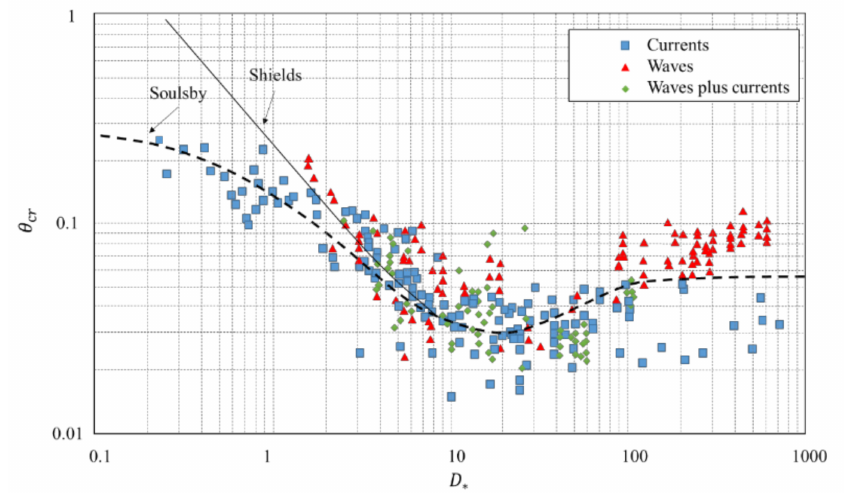
Figure 1. Threshold of motion curve, modified from